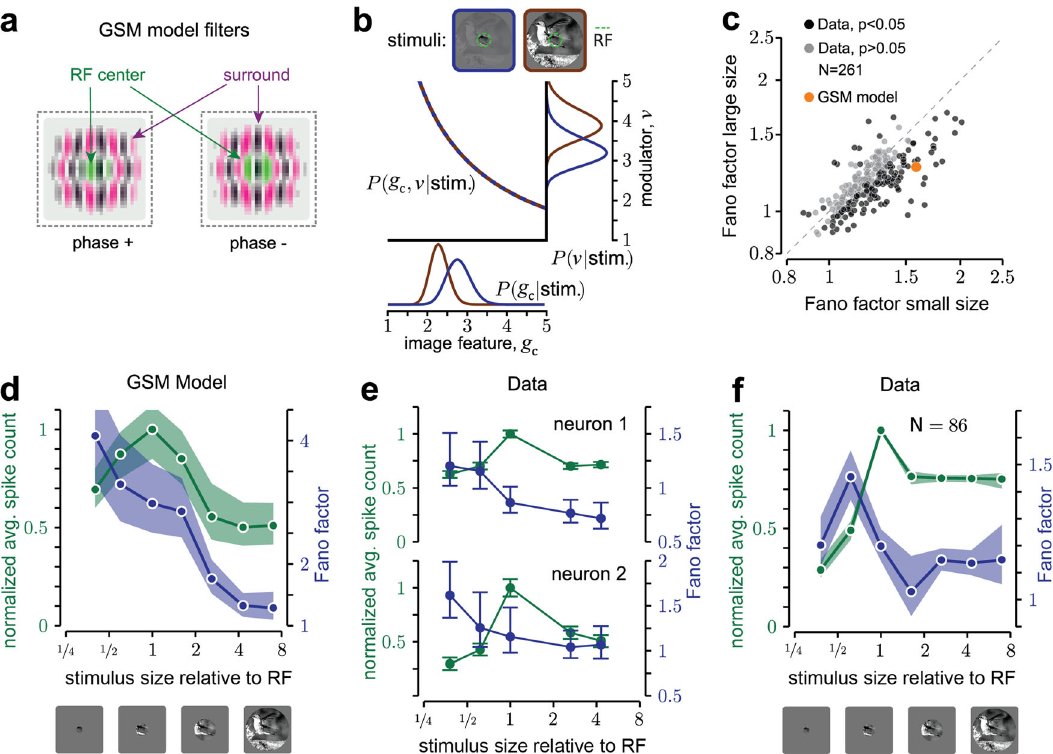
Fig. 2 Surround stimulation reduces GSM uncertainty and V1 variability for natural images. a In the GSM, the inputs to the model neuron are provided by the activity of quadrature pairs of oriented fi lters, corresponding to the spatial RF (green) and its surround (magenta). b Noise-free GSM model applied to an image without (blue) and with (brown) surround. The surround stimulus does not change the constraint between g c (the local feature associated with the RF center) and ν , but it in fl uences the estimate of the modulator and therefore also the estimate of g c . c FF averaged across small (1°) and large (3.1° or 6.7°) natural image patches. Black and gray circles: average FF across images for each V1 neuron; black denotes a signi fi cant difference ( p < 0.05) across the two conditions. Orange circle: average FF of the GSM response for the same set of images. For the conversion to spike counts (see Methods, Eq. 4) we used the scaling factor c = 2. The p values were computed with a two-sided paired sample t test, of the null hypothesis that the difference between the two conditions had mean equal to 0. d – f Tuning of the mean spike count (green) and FF (blue), for natural image patches of varying size. d GSM model, scaling factor c = 15. This constant was different than in ( c ), because the experiments of ( c ) used images with a broader range of orientation and frequency content than ( d ). e Data from one awake fi xating macaque V1, for two example neurons and a single image presented at different sizes. Mean rate (green dots) and FF (blue dots) have been computed over 110 stimulus presentations. f Population average across neurons (86 in total) and image patches (10 in total). The error bars in ( d , e , f ) represent the 68% c.i. and are computed by